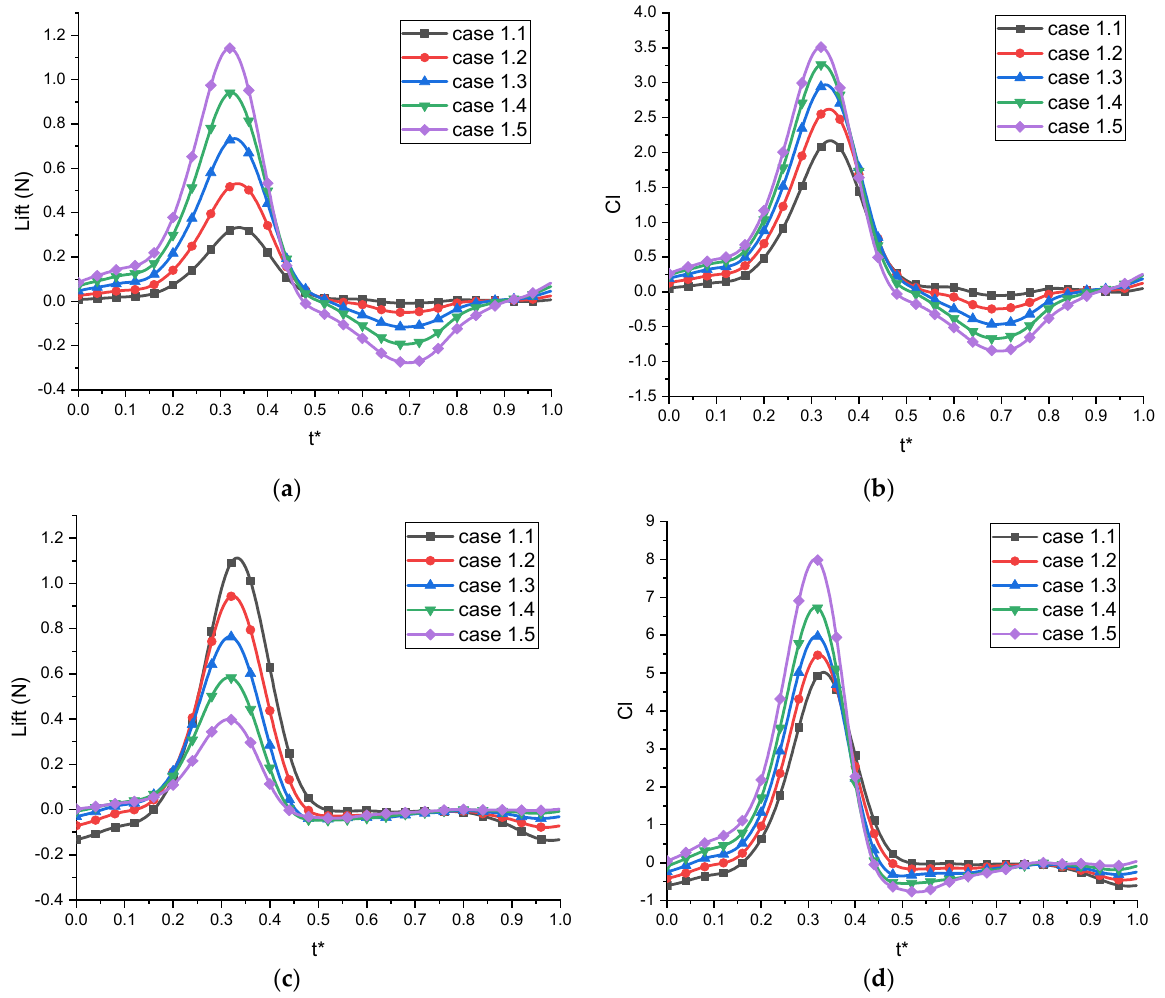
Figure 11. Separated inner and outer wing lift: ( a ) inner wing lift; ( b ) inner wing lift coefficient; ( c ) outer wing lift; ( d ) outer wing lift coefficient.